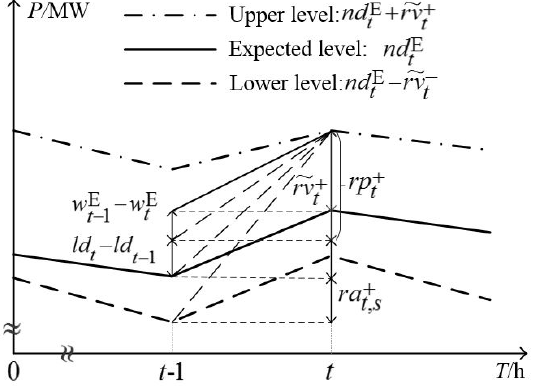
Figure 5. Ramping reserve requirements.